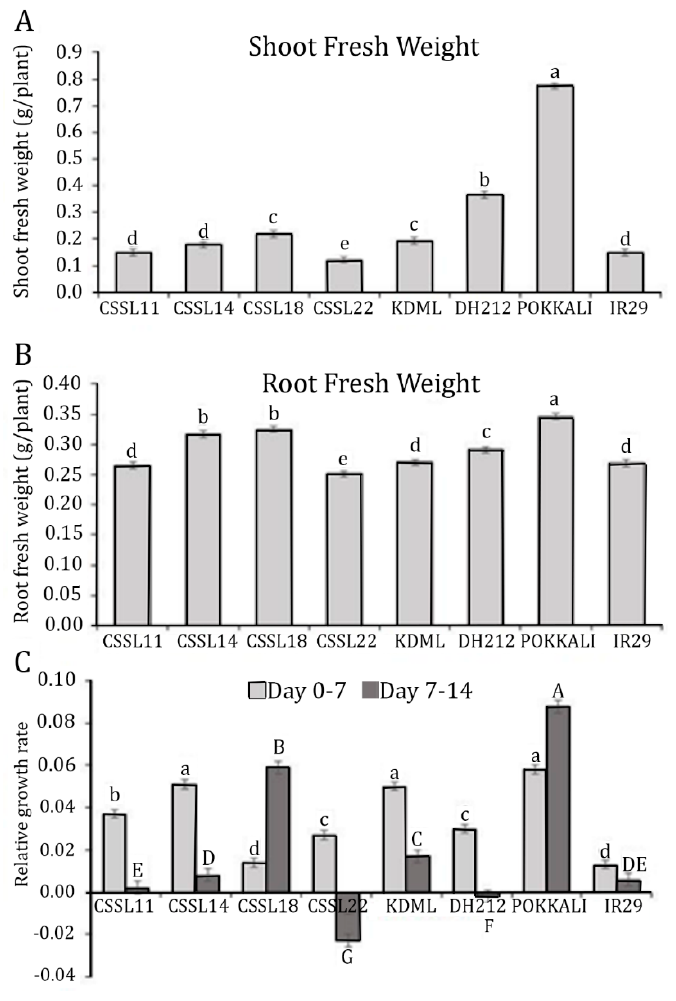
Figure 3. Growth of CSSLs, parental lines (‘KDML105’ and DH212), and salt-tolerant (‘Pokkali’) and salt-susceptible (IR29) lines, determined by shoot fresh weight ( A ), root fresh weight ( B ), and relative growth rate during 0–7 days and 7–14 days of salt stress ( C ). The di ff erent lower case letters or capital letters show the significant di ff erence of means, p < 0 . 05 .